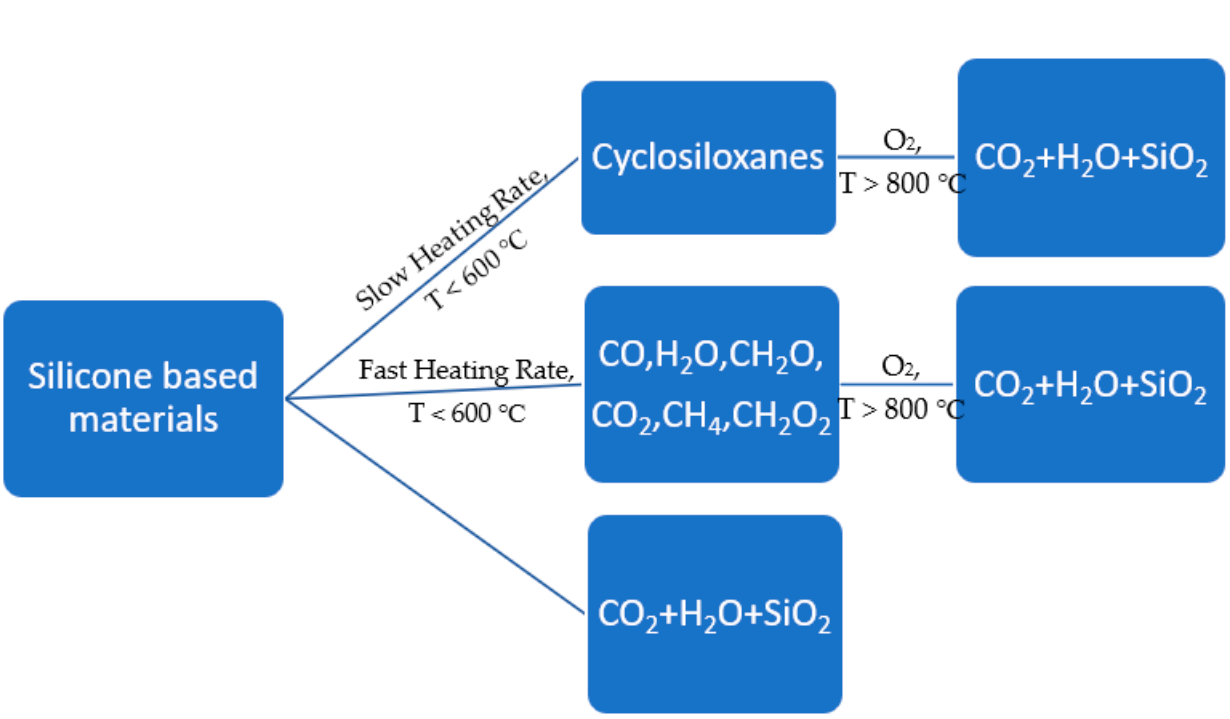
Figure 12. Representation of the products of thermal oxidation of silicone-based materials under different conditions [146].